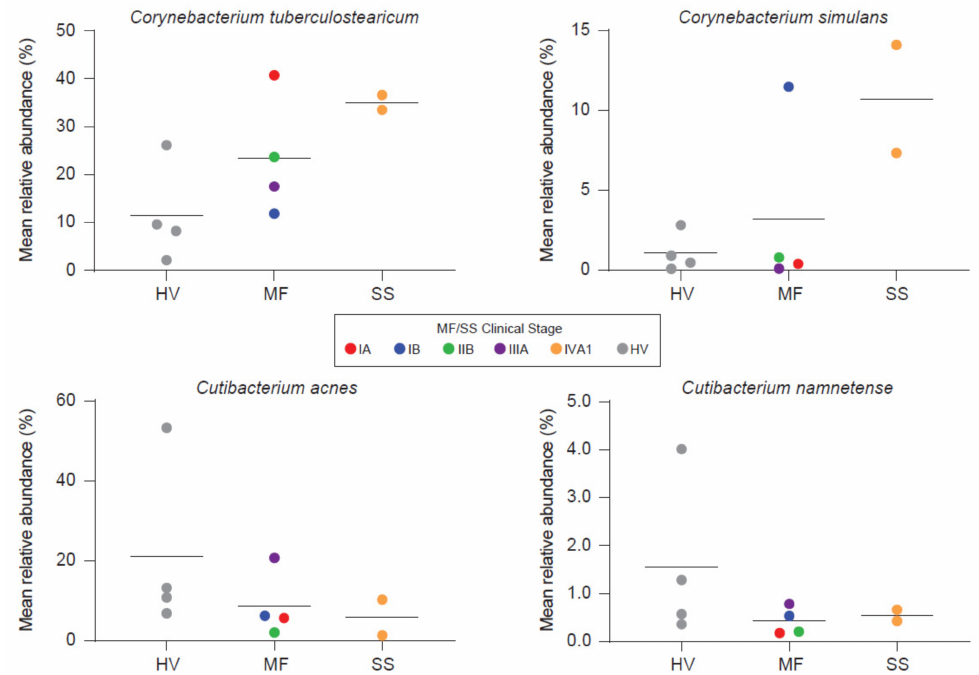
Figure 3. Besides Staphylococcus aureus , other organisms may also be linked with CTCL. Harkins et al. [20] found two corynebacteria to trend higher, whereas two cutibactactial species exhibited decreased abundances on CTCL lesions. Bacterial shifts seem to correlate with disease stage. HV = Healthy Volunteer. Reprinted with permission from ref. [20]. Copyright © 2021 Elsevier. However, statistical significance was not reached, likely due to the small sample number [20]. C. tuberculosearicum can upregulate and/or induce inflammatory responses in keratinocyte derived cell lines in vitro and may contribute to cutaneous malignancies